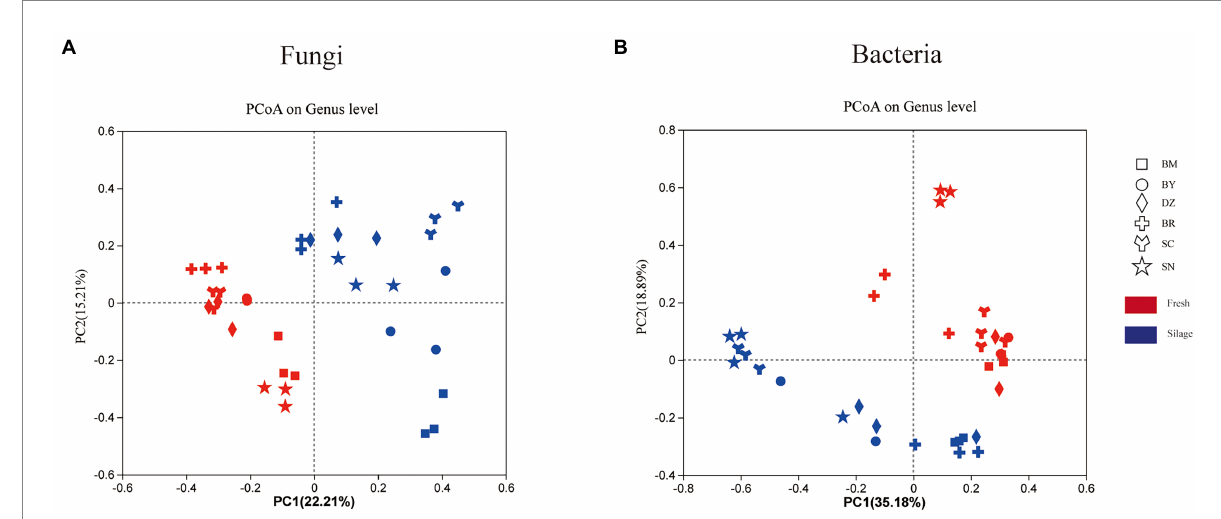
FIGURE 2 The unweighted Principal coordinate analysis (PCoA) of fungal (A) and bacterial (B) communities of fresh and ensiled oat along the elevation gradient on the Tibetan Plateau. BM, Bomi County; BY, Bayi County; DZ, Dazi County; BR, Biru County; SC, Suo County; SN, Seni